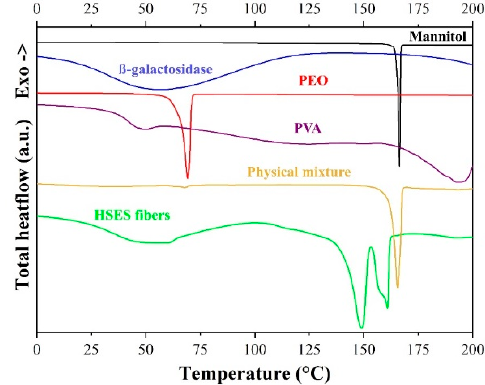
Figure 4. Differential scanning calorimetry (DSC) thermograms of δ -mannitol, β -galactosidase, polyethylene oxide (PEO), polyvinyl alcohol (PVA), the physical mixture of the fiber components, and the ground electrospun PVA + PEO + mannitol + β -galactosidase (high-speed electrostatic spinning (HSES) fibers).